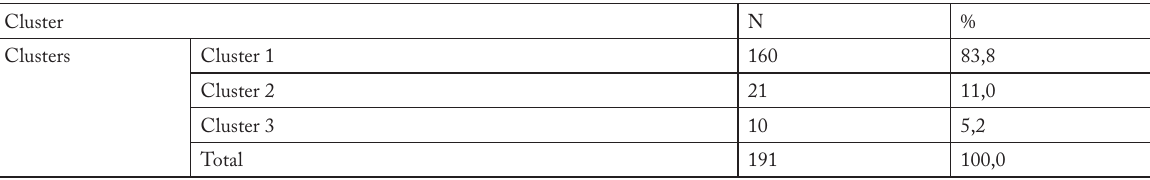
Table 5. Distribution of clusters according to the two-step clustering. Cluster